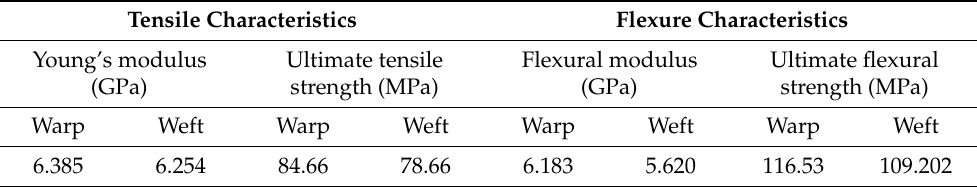
Table 3. Tensile and flexural properties of the woven Flax/Bio epoxy (WFBE) composite.